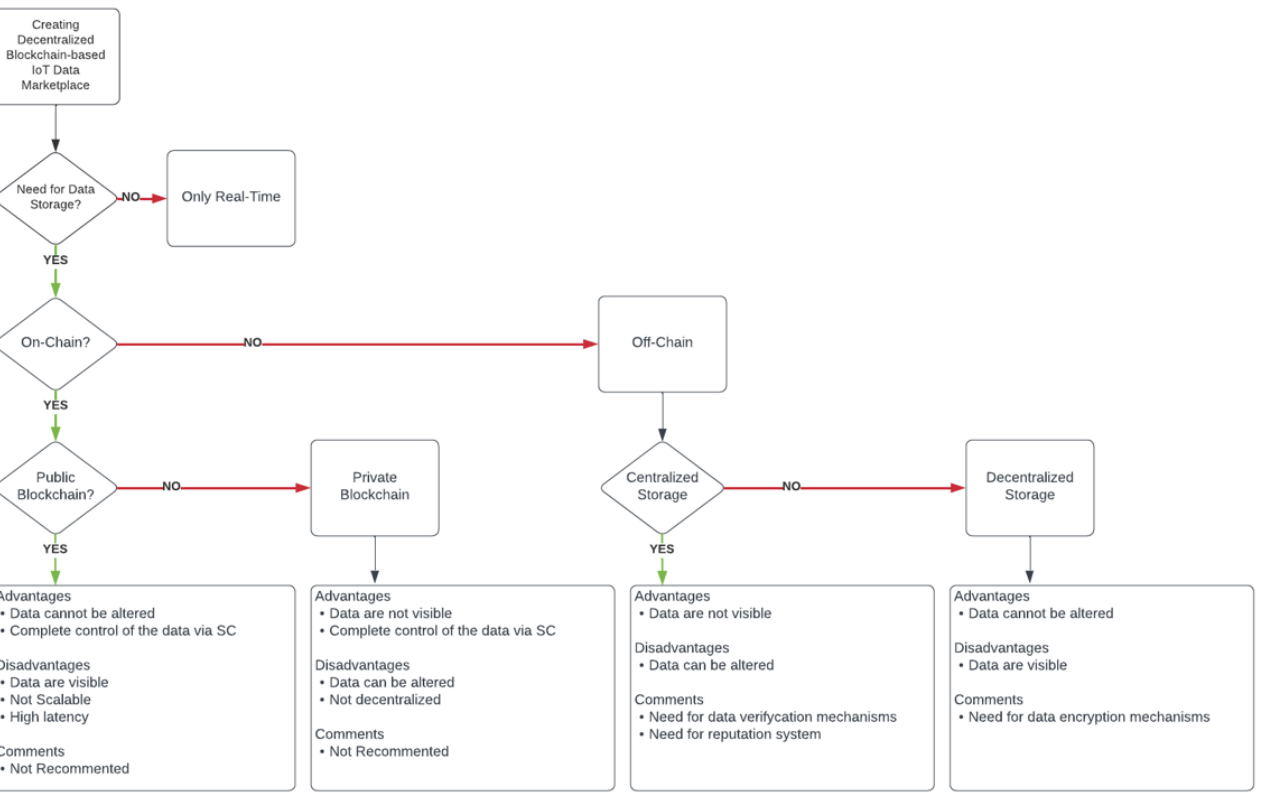
Figure 1. Schematic view of a systematic decision process for the design or selection of an IoT data marketplace solution.